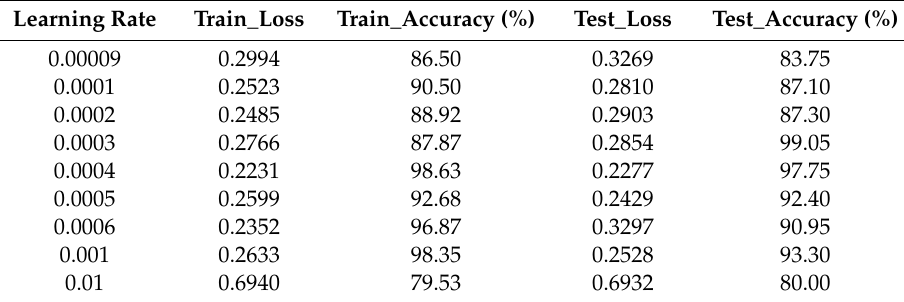
Table 3. The loss and accuracy results of di ff erent learning rates.